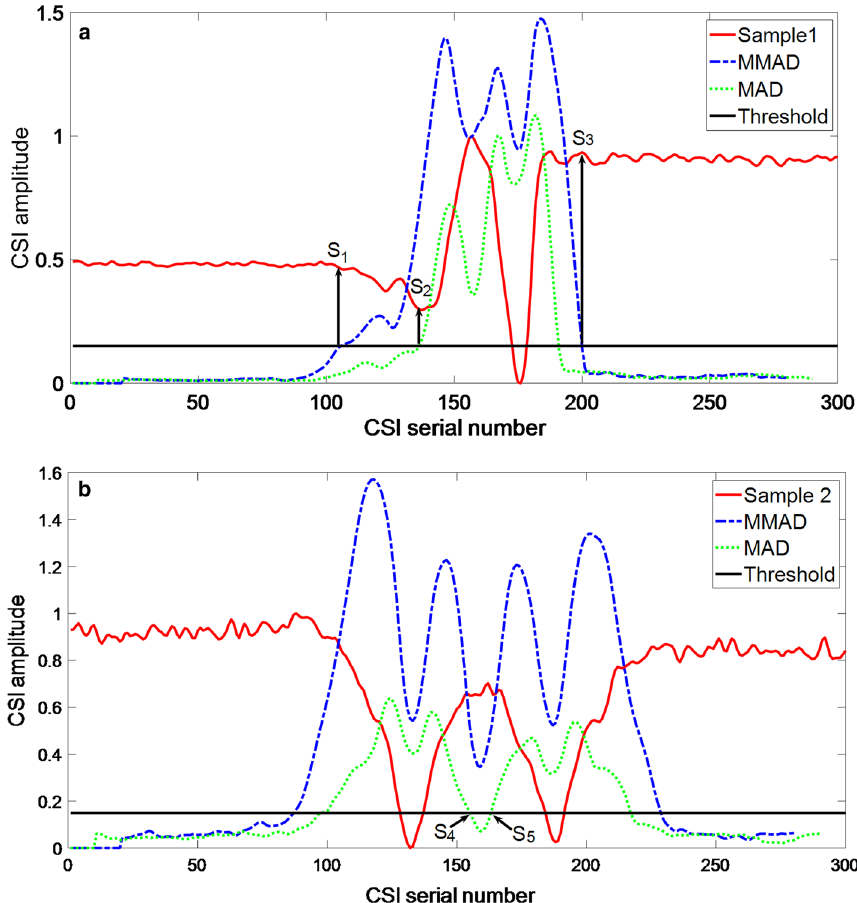
Fig. 4 Comparison of MMAD and MAD